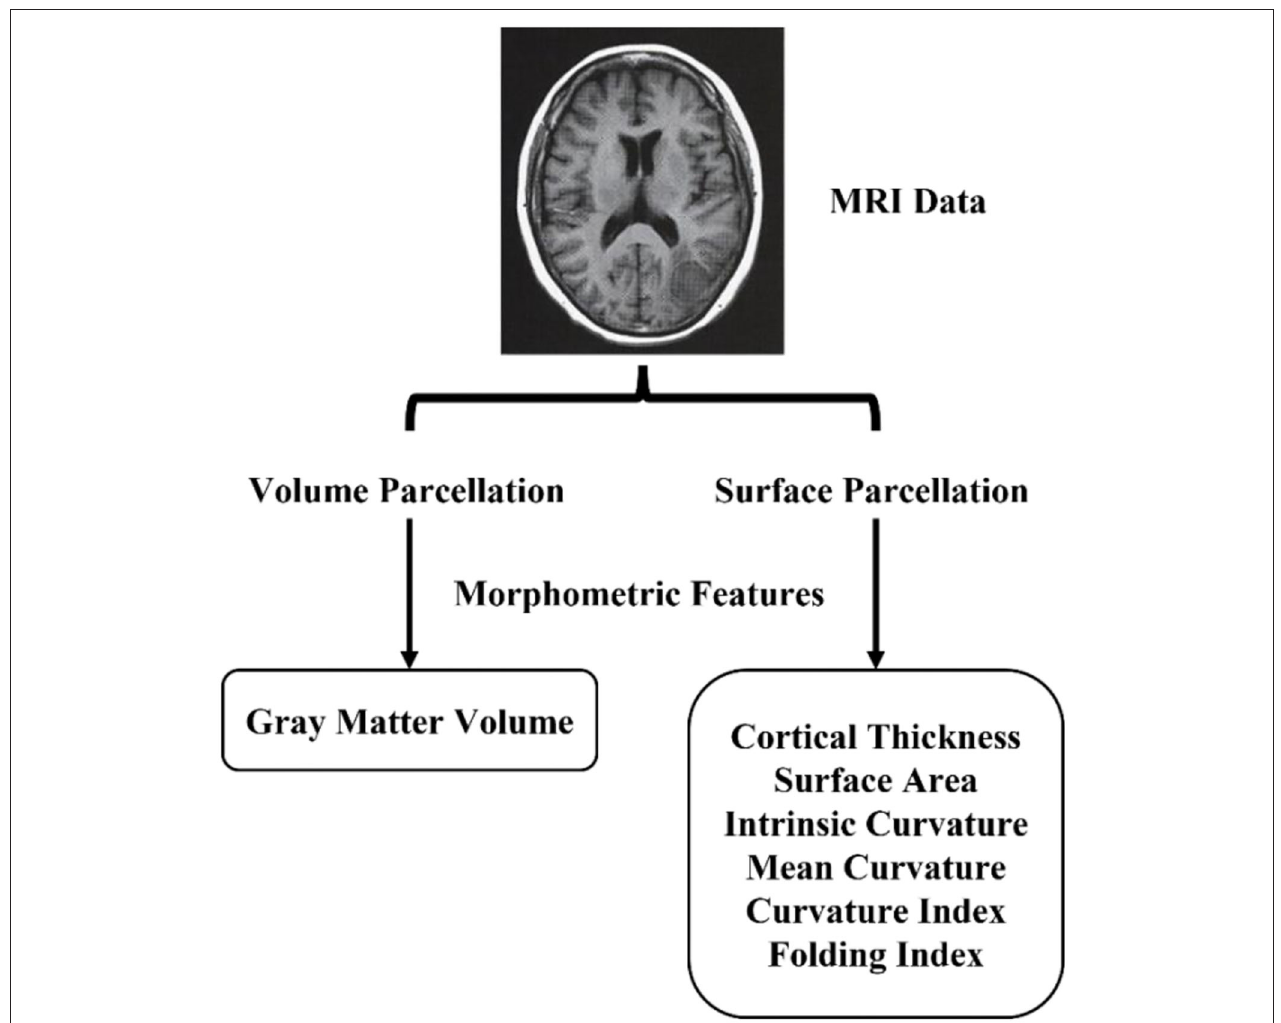
FIGURE 2 | Morphometric features extraction